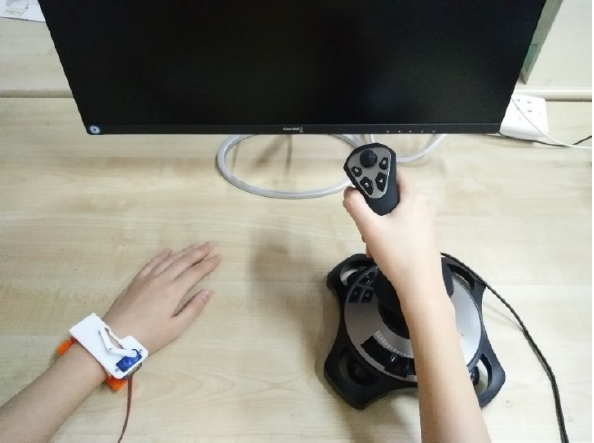
Figure 10. Virtual field test with the designed guidance wristband and feedback joystick.